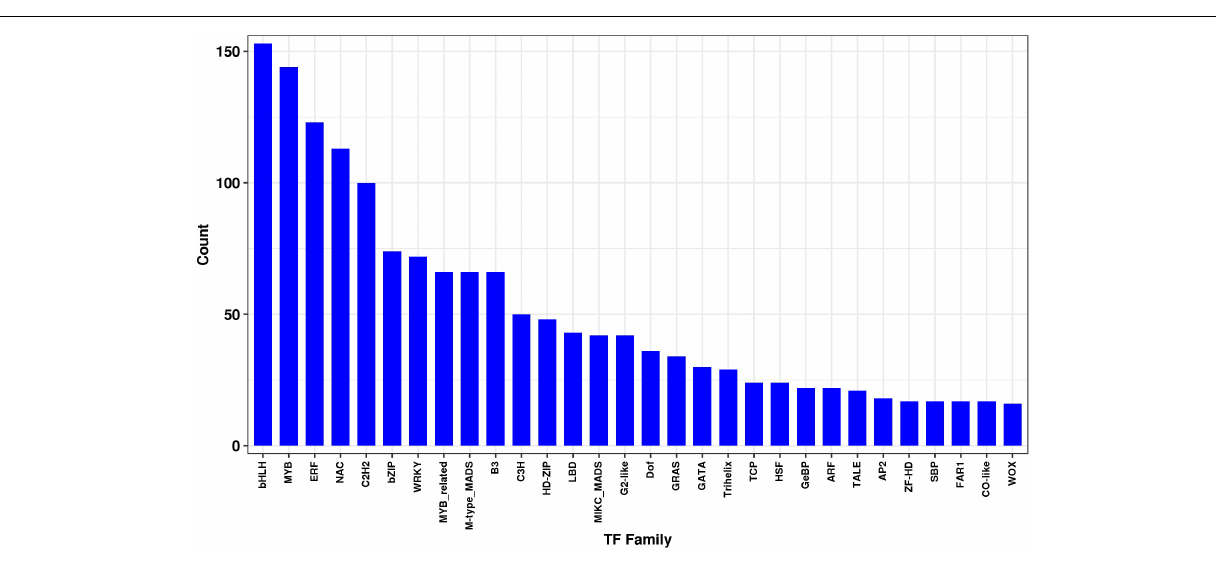
FIGURE 9 | Transcription factor family. The horizontal coordinates are different transcription factor families, and the ordinates are the number of genes that fall into that transcription factor